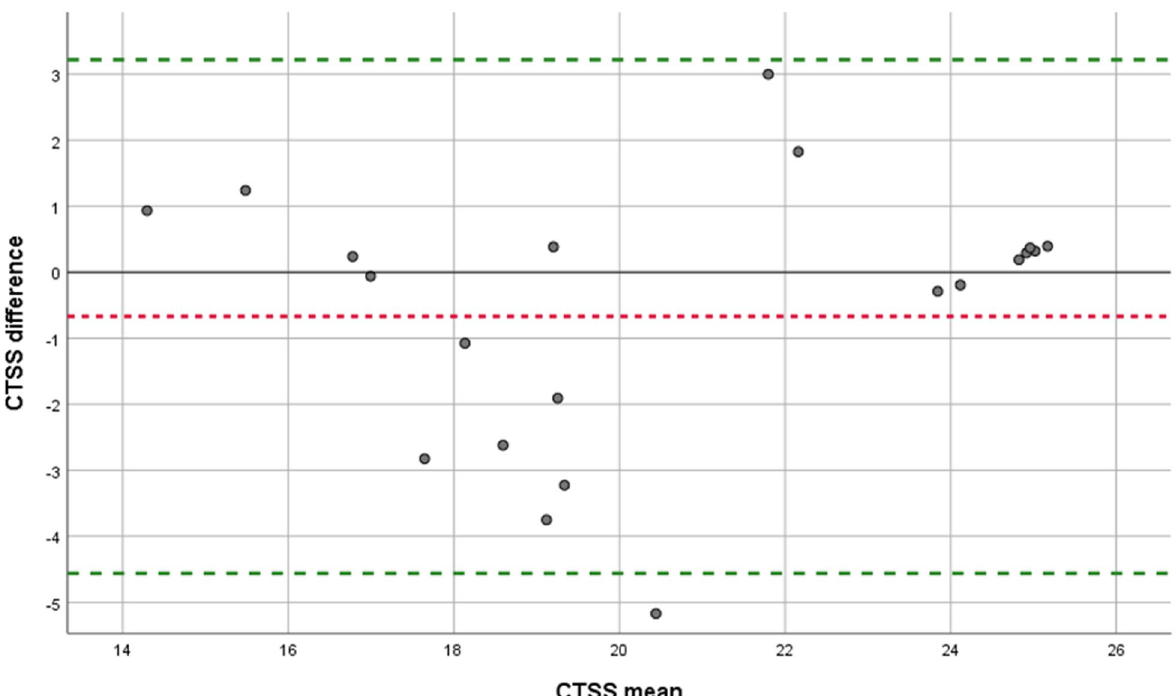
Fig. 3 Bland–Altman plot for CTSS. CTSS: Computed tomography severity score. Each point represents agreement between the two raters RvH and BT. A jitter effect was added to improve visualization of data and avoid direct overlap of multiple examinations. Green dotted line: limits of agreement. Red dotted line: mean systematic